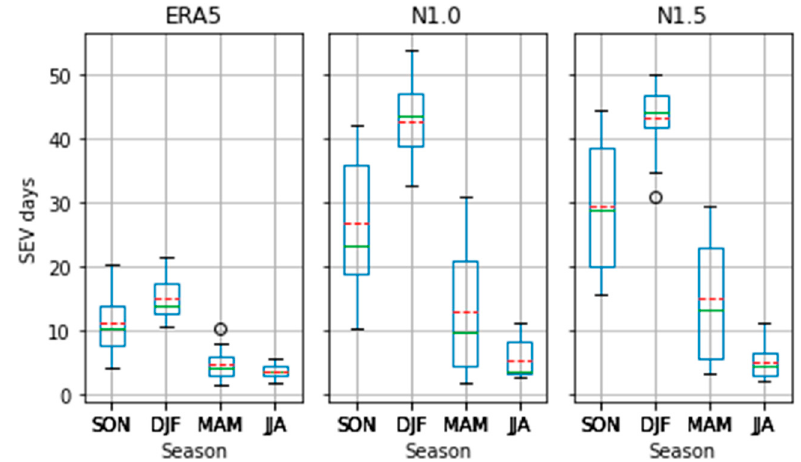
Figure 14. Box and whisker plots of the number of days with severe thunderstorm potential for the four seasons (SON, DJF, MAM, JJA) from the land grid points of the d02 domain of ERA5, N1.0 and N1.5 ensemble mean. The green line (red dash line) is the medium (mean) value.